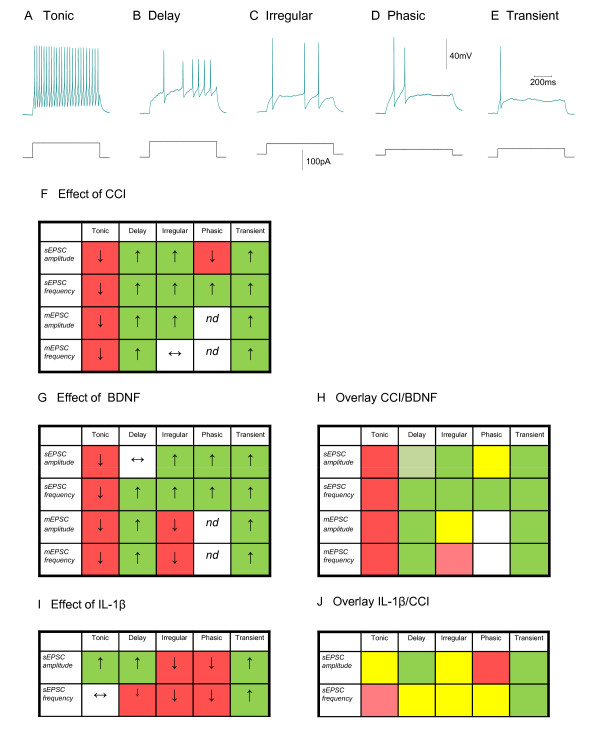
Neuron types and injury footprints produced by CCI and BDNF. A-E Firing patterns of tonic, delay, irregular, phasic and transient neurons in response to depolarizing current commands. F. Injury footprint produced by CCI. Neuron types are listed across the top of the scheme and four indices of excitatory synaptic transmission are listed to the left. Neuron specific parameters increased (↑; such as sEPSC amplitude in delay neurons) are coded green. Neuron specific parameters decreased (↓; such as sEPSC amplitude in tonic neurons) are coded red. Data from [107]. nd = not determined. G. Injury footprint produced by BDNF. Neuron types are listed across the top of the scheme and four indices of excitatory synaptic transmission are listed to the left. Neuron specific parameters increased (↑; such as sEPSC amplitude in delay neurons) are coded green. Neuron specific parameters decreased (↓; such as sEPSC amplitude in tonic neurons) are coded red. Data from [24]. H. Overlay of the injury footprints from F and G, similarities between the actions of CCI and BDNF treatment show up as clear green or red squares. Yellow squares illustrate the few parameters which appear to be altered in a different way by BDNF compared to CCI. 2 out 20 (10%) of squares are yellow. I. Injury footprint produced by IL-1β. Neuron types are listed across the top of the scheme and indices of excitatory synaptic transmission SEPSC amplitude and frequency are listed to the left. Neuron specific parameters increased (↑) are coded green. Neuron specific parameters decreased (↓) are coded red. J. Overlay of IL-1β injury footprint from I with sEPSC amplitude and frequency data from A. Yellow squares illustrate the parameters which appear to be altered in a different way by IL-1β compared to CCI. 5 out of 10 (50%) of squares are yellow. This analysis indicates that the consequences of CCI are mimicked more accurately by BDNF than by IL-1β.